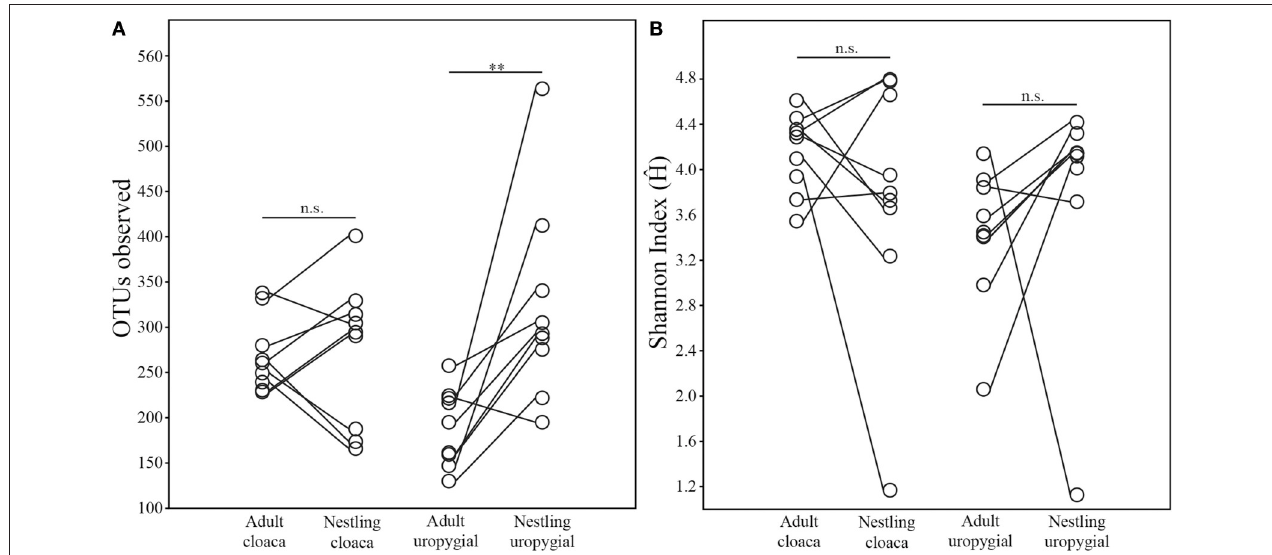
FIGURE 2 | Comparisons of similarities between the (A) richness (OTUs observed) and (B) broader alpha diversity (nonparametric Shannon Index) of the cloacal and uropygial gland microbiota of adult and nestling juncos. Comparisons between age classes reflect average values paired by nest (** p ≤ 0.01).